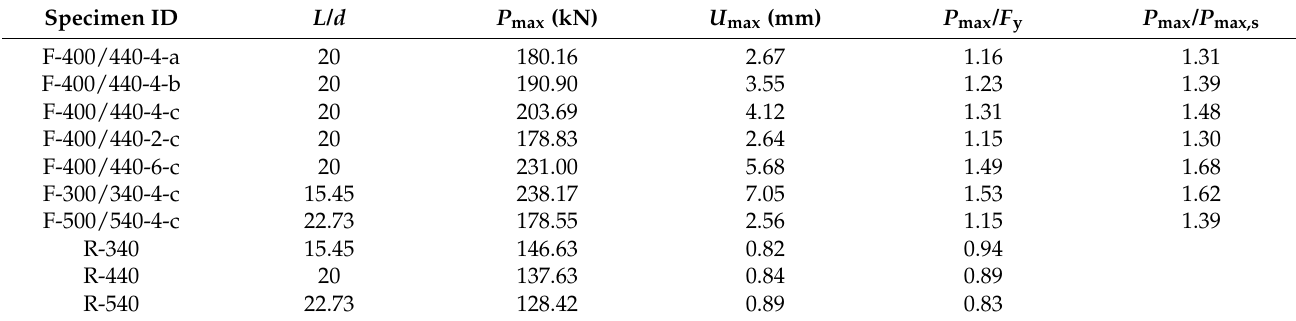
Table 5. Test results for specimens.